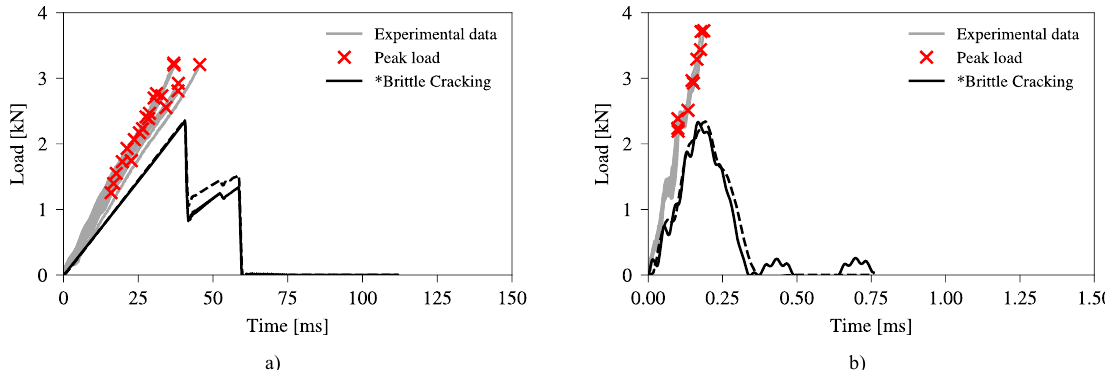
Fig. 10 Simulation results for the *Brittle Cracking model compared to experimental data for target piston velocities of a) 10 mm/s and b) 1000 mm/s. (― load ring; - - - support